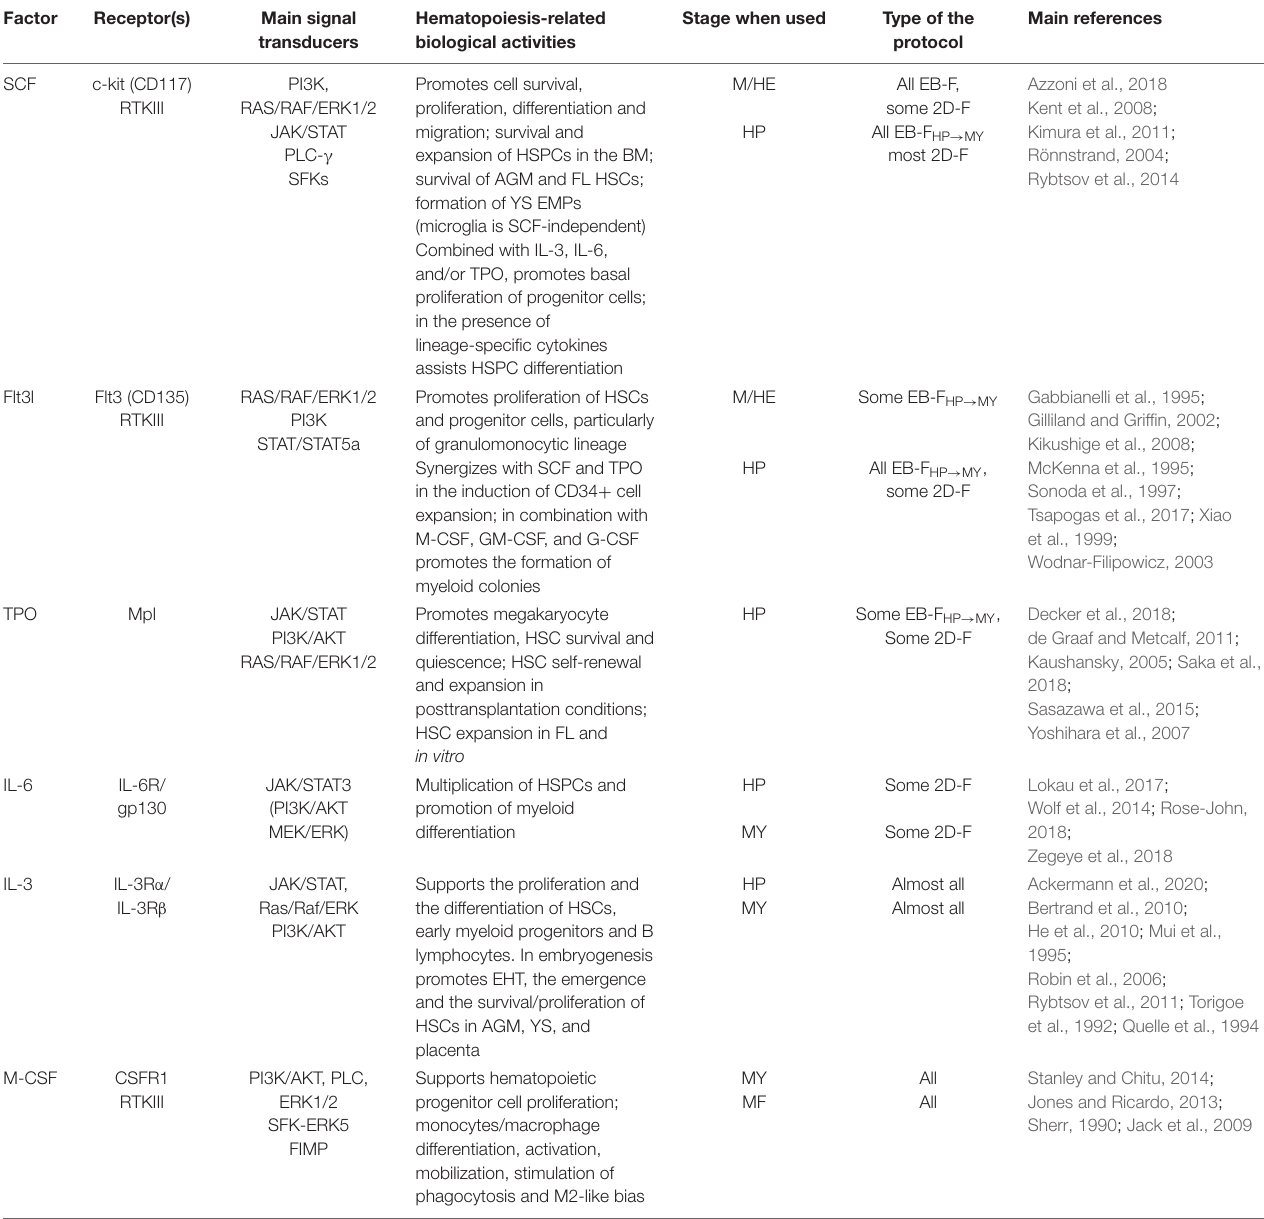
TABLE 4 | Exogenous factors used during HP and MY stages of iMph